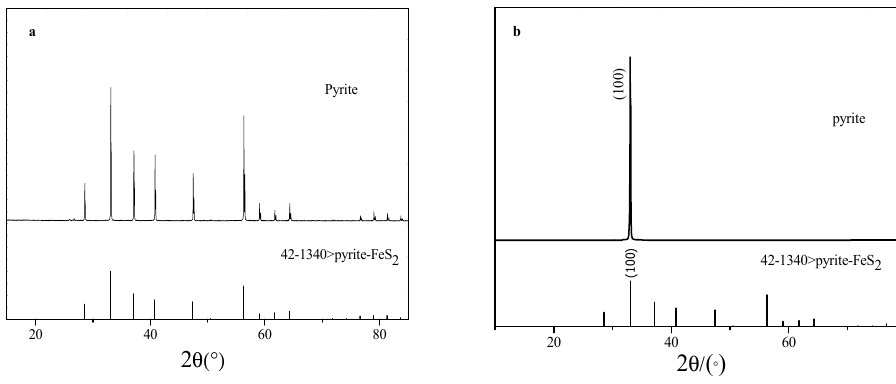
Figure 1. X-ray diffraction (XRD) patterns of powder pyrite ( a ), and pyrite (1 0 0) ( b ).